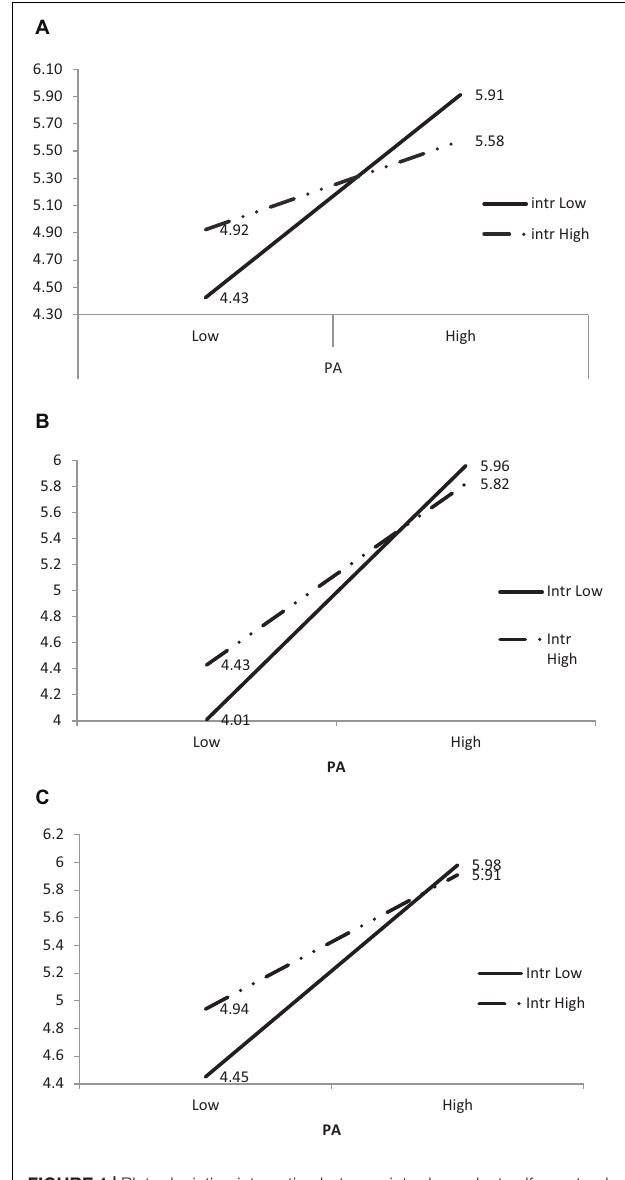
FIGURE 1 | Plots depicting interaction between interdependent self-construal, positive and negative affect in social interaction and the three social interaction outcomes. (A) Effects of High and Low levels of Interdependent self-construal and PA on attending to others’ emotions. (B) Effects of High and Low levels of Interdependent self-construal and PA on satisfaction with the social interaction. (C) Effects of High and Low levels of Interdependent self-construal and PA on perceiving the other expressing positive